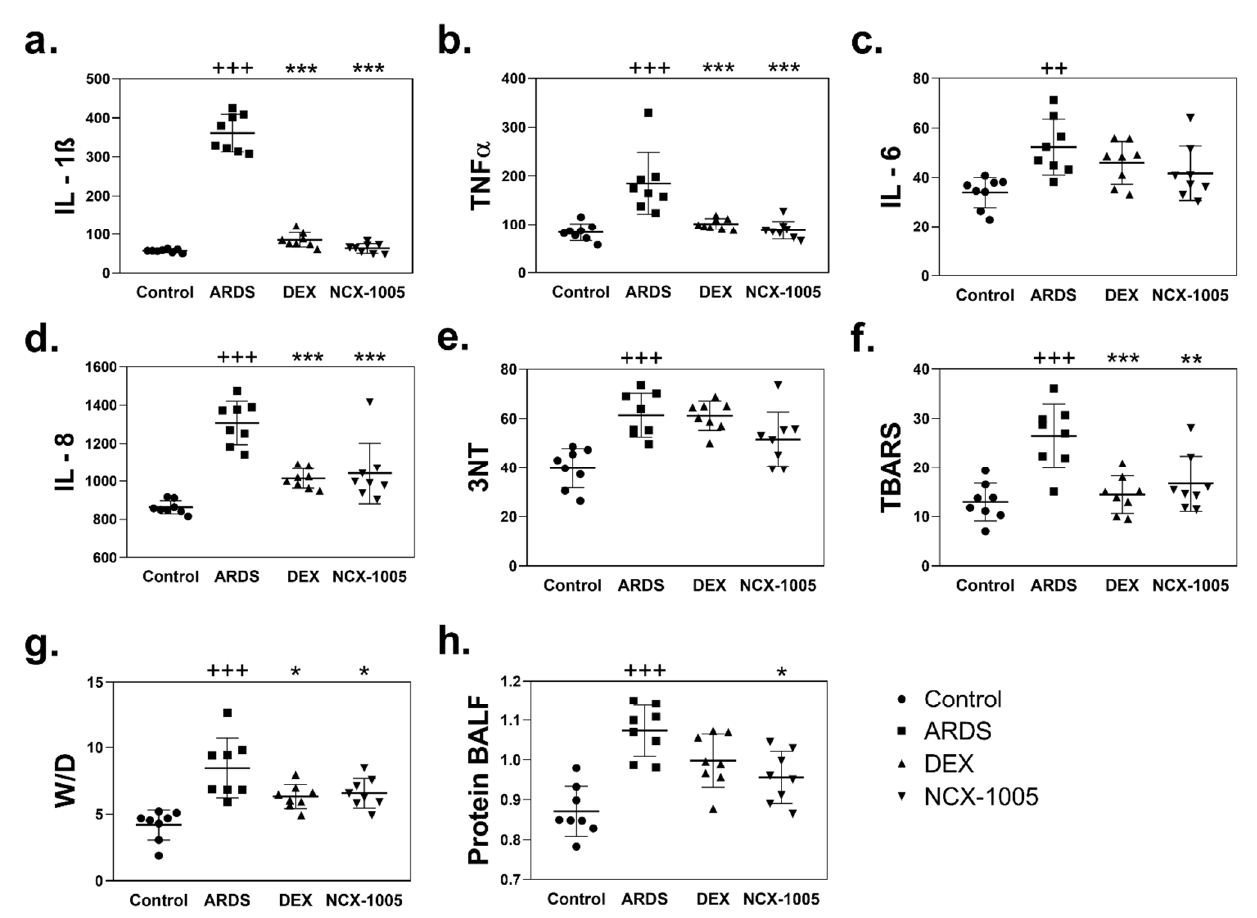
Figure 3. Degree of inflammation, oxidation, and lung oedema formation in lung. Levels of cytokines ( a ) IL-1 β , ( b ) TNF α , ( c ) IL-6, and ( d ) IL-8 (all in pg/mL); oxidation of ( e ) protein (3-nitrotyrosine, 3NT, nmol) and ( f ) lipid (thiobarbituric acid- reactive substances TBARS, mmol MDA) in lung homogenates; ( g ) lung oedema expressed as wet–dry (W/D) lung weight ratio; and ( h ) protein content in bronchoalveolar lavage fluid (BALF, µ g/mL) in Control group, ARDS-untreated group, and ARDS group treated with dexamethasone or NCX-1005. Data are presented as individual values with mean ± SD. Statistical comparisons: for ARDS vs. Control ++ p <0.01, +++ p < 0.001 and for DEX and NCX-1005 vs. ARDS * p < 0.05, ** p < 0.01, *** p < 0.001. Table 3. Degree of inflammation and oxidation in plasma at the end of experiment. Levels of cytokines, IL-1 β , TNF α , IL- 6, and IL-8 (all in pg/mL) and protein (3-nitrotyrosine, 3NT, nmol) and lipid oxidation (thiobarbituric acid-reactive sub- stances TBARS, mmol MDA) in Control group, ARDS-untreated group, and ARDS group treated with dexamethasone or with NCX-1005. Data are presented as means ± SD. Statistical comparisons: for ARDS vs. Control † p < 0.05, †† p < 0.01, ††† p < 0.001; and for NCX-1005 vs. ARDS * p < 0.05.